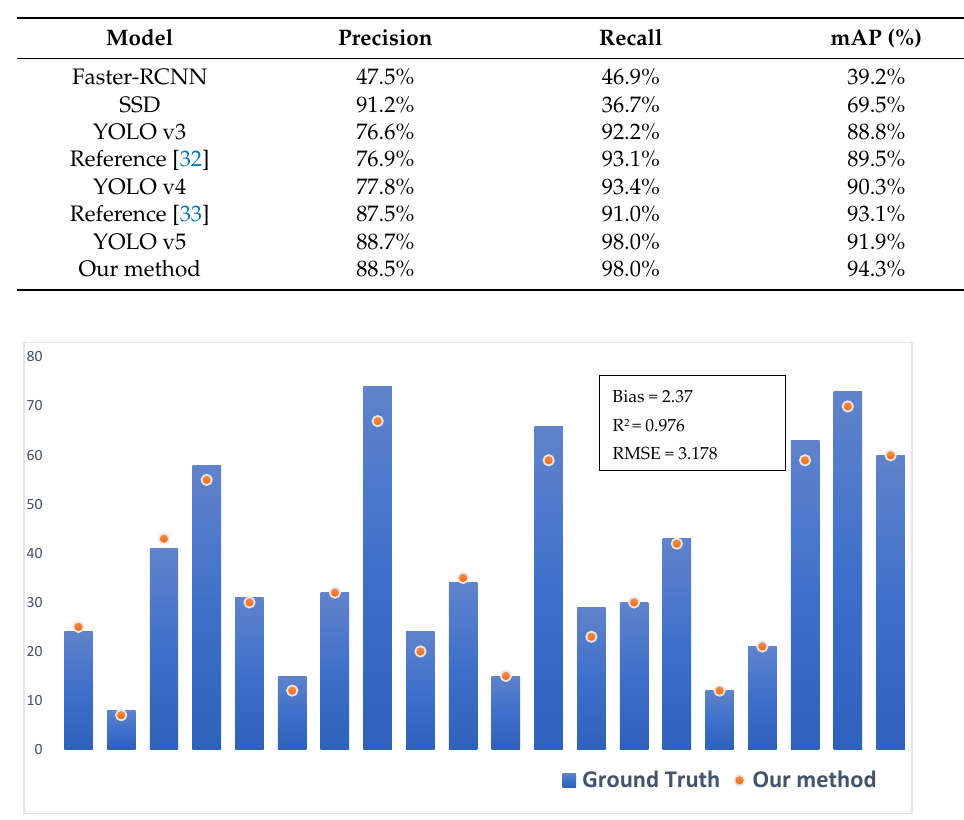
Figure 14. The comparison between the true value and the estimated value of a single image.